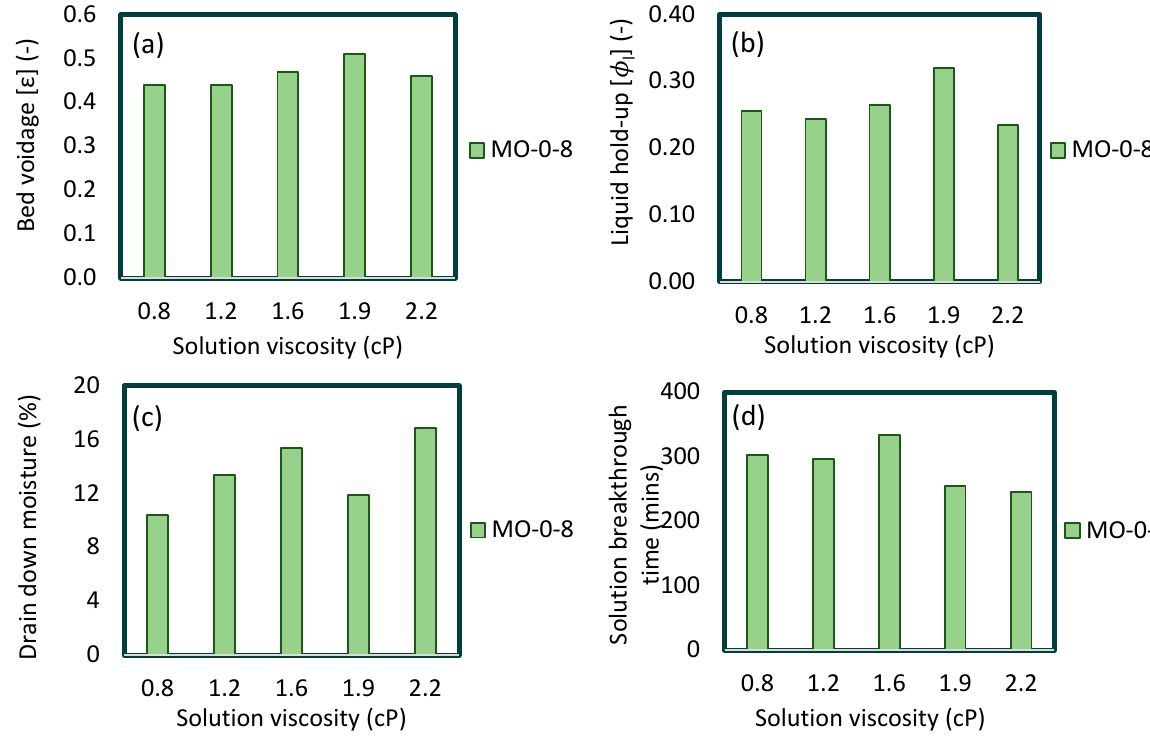
Figure 14. ( a ) Bed voidage, ( b ) total liquid hold-up, ( c ) 24-h drain-down moisture, ( d ) solution breakthrough time characterisation data for beds composed of 0-8 mm MO particles and irrigated with different viscosity solutions (0.8. 1.2, 1.6, 1.9, and 2.2 cP).